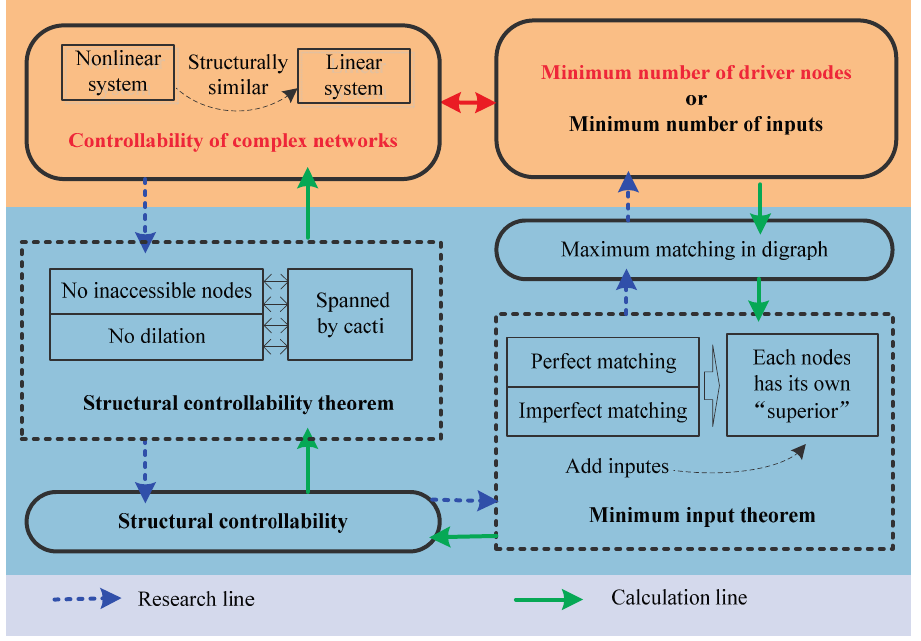
Figure 1. Framework to solve